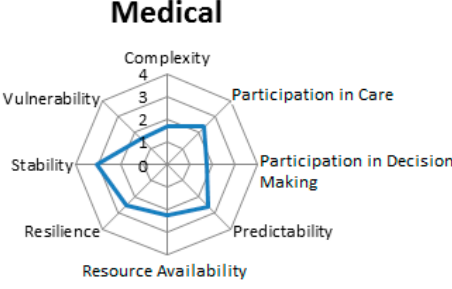
Figure 1. Spider Chart of Mean Synergy Scores for Patients on the Hamilton Health Sciences Corporation (HHSC) Medical Unit.